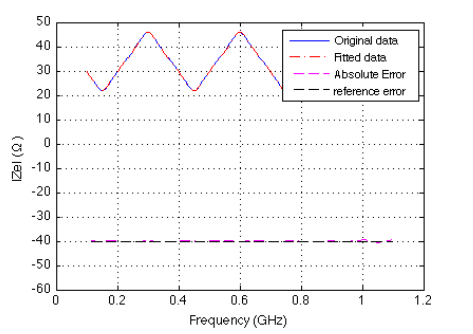
Figure 6. Impedance seen from the input of the line for a -20 dB error